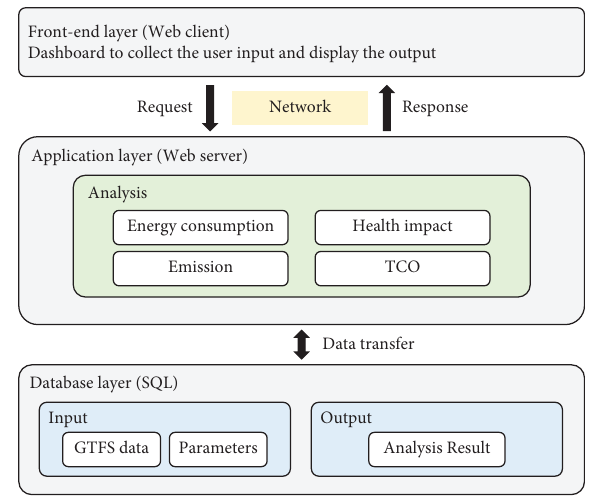
Figure 4: Software architecture for the online